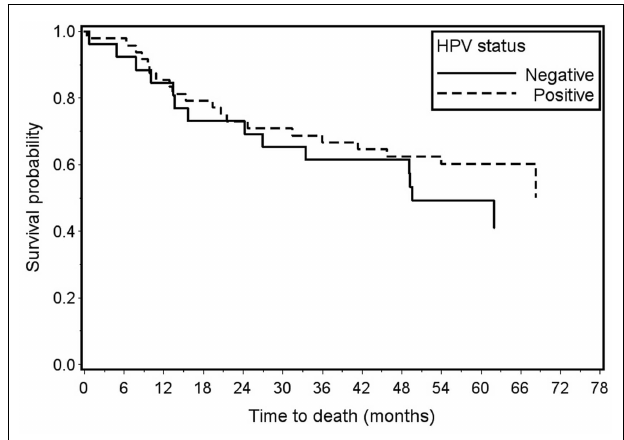
FIGURE 1 | Overall survival of invasive penile cancer cases by HPV status: any HPV + ( n = 48) vs. HPV − ( n = 26) Log-rank p -value = 0.37